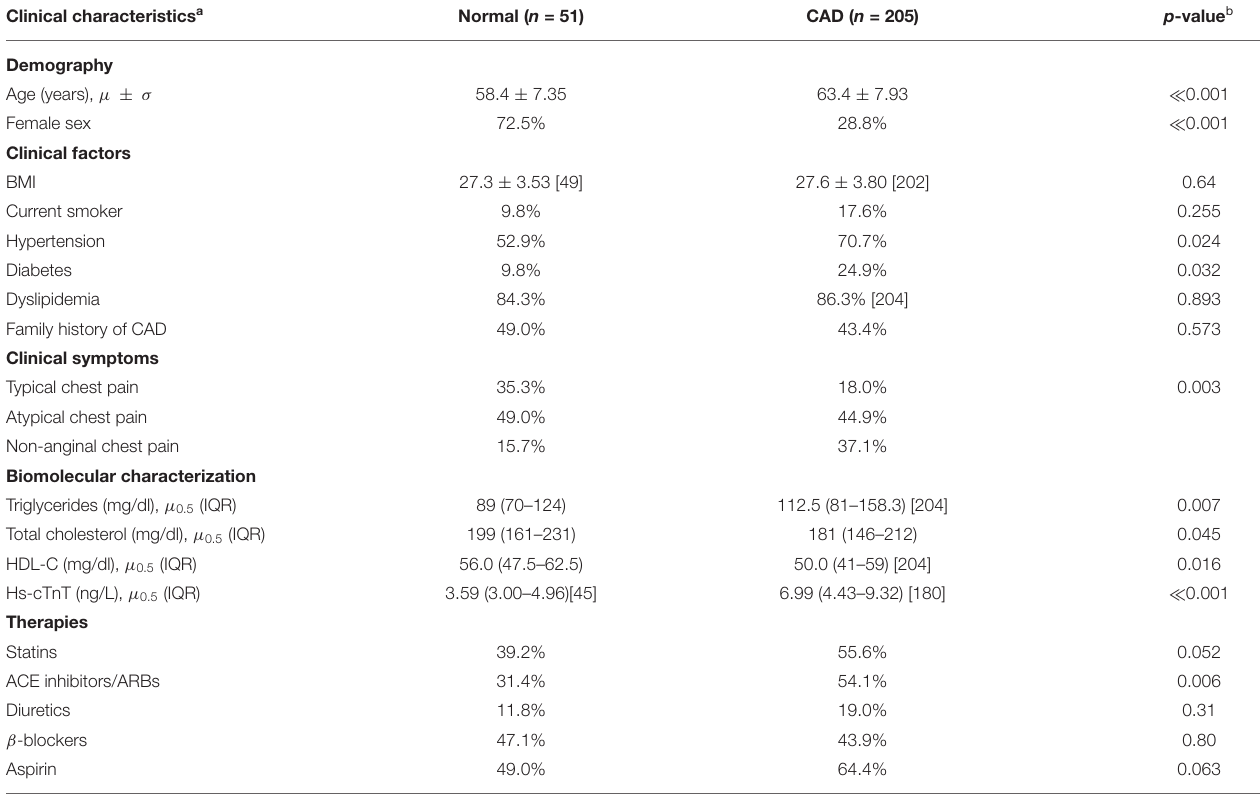
TABLE 1 | Selected demographic and clinical